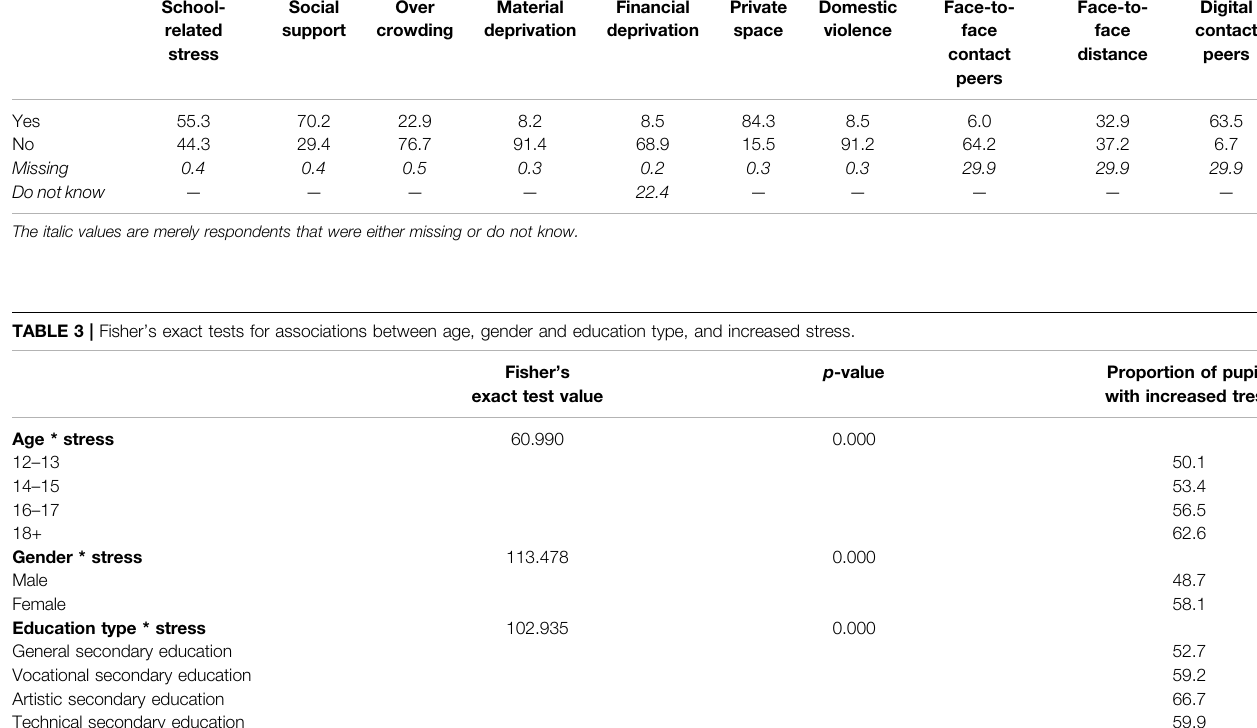
TABLE 2 | Descriptive overview of school-related stress, learning-, family-, and peer-related factors in % (n = 16,163).